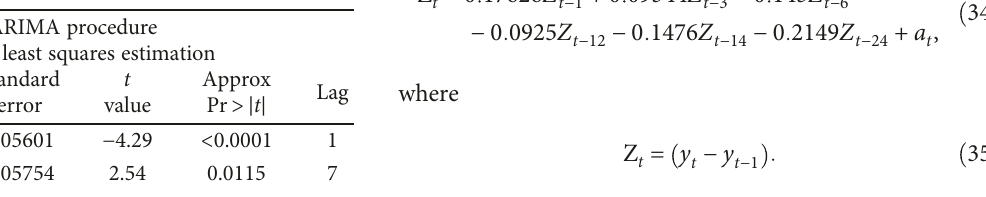
Figure 2: Time plot for wheat price (unit: US dollars per metric ton). Table 6: Parameter estimates for wheat